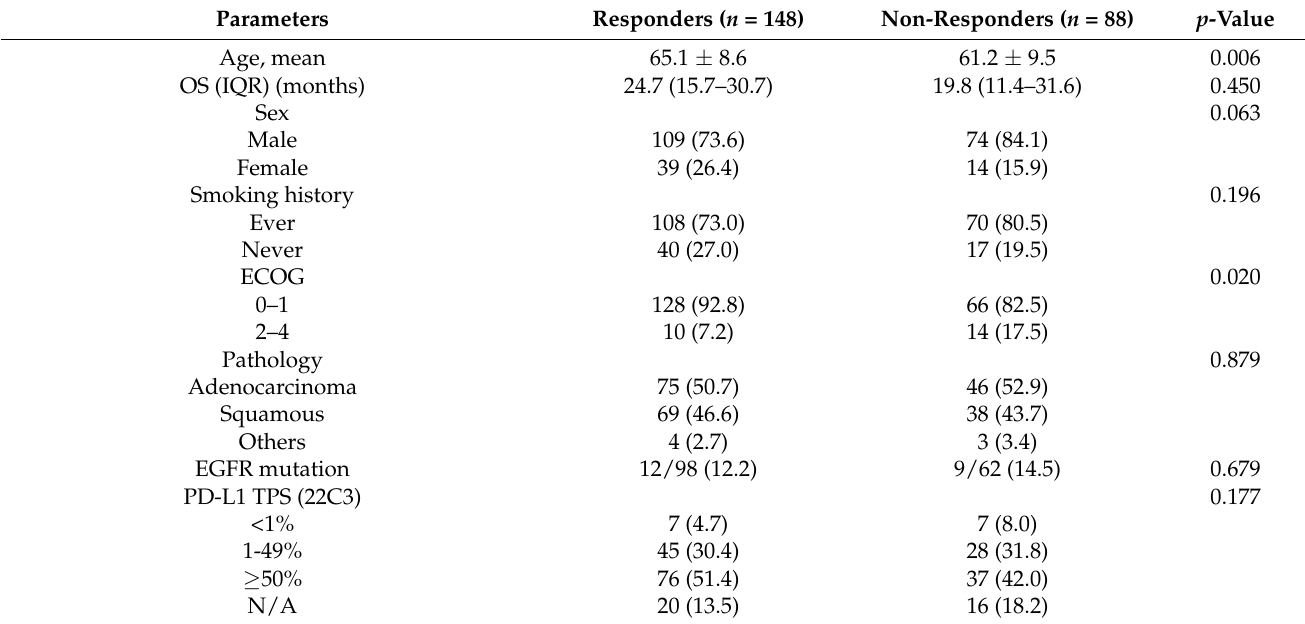
Table 1. Comparison of responders and non-responders among overall